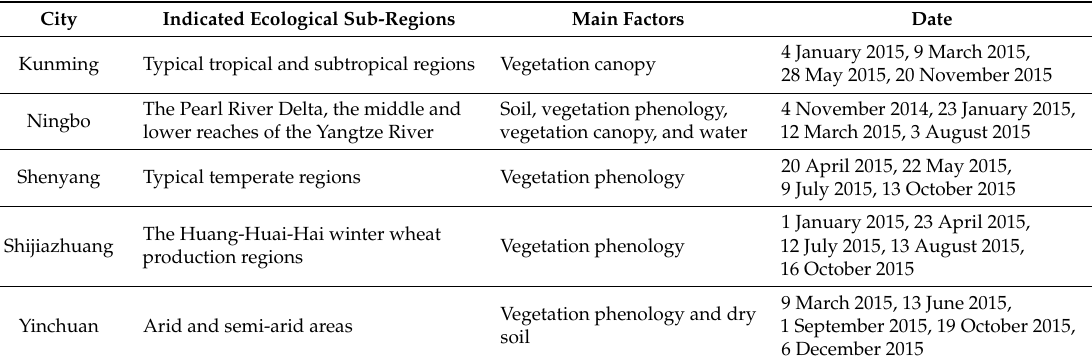
Table 1. Various factors and Landsat 8 OLI images of cities investigated in this